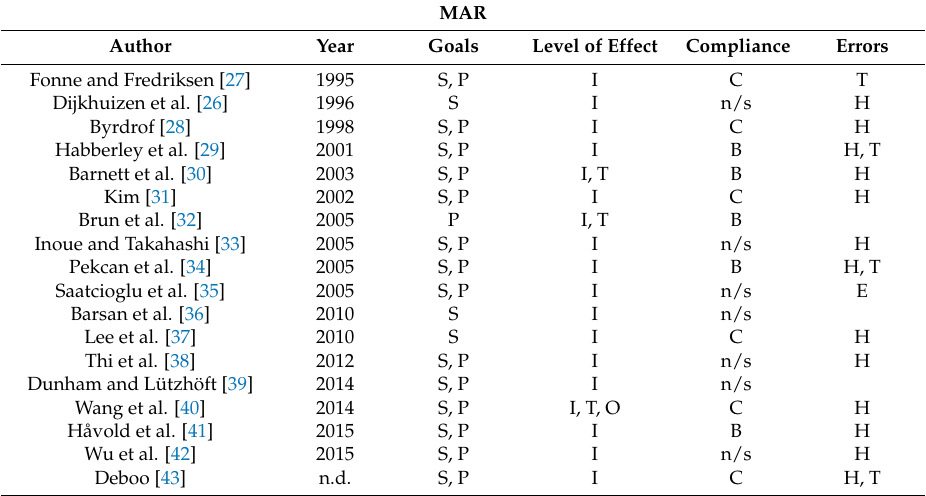
Table A1. Characteristics of studies meeting selection criteria for conceptualisation